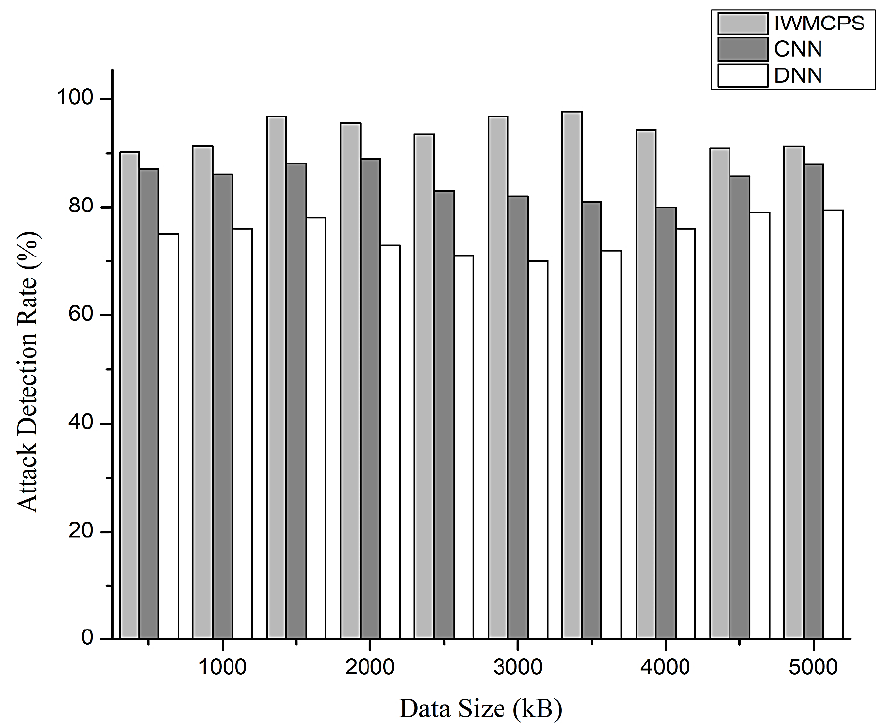
Figure 8. ( a ) Accuracy analysis and ( b ) efficiency analysis.